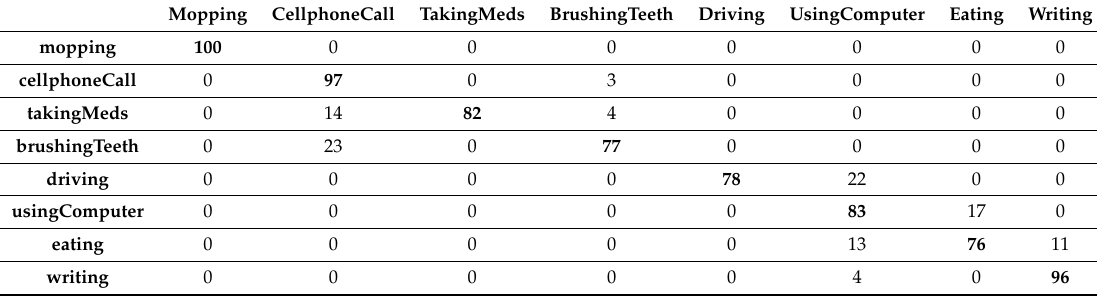
Table 3. Confusion matrix for Analysis 3 . The value in each cell represents the percentage that the row’s activity observation is matched to the column’s activity